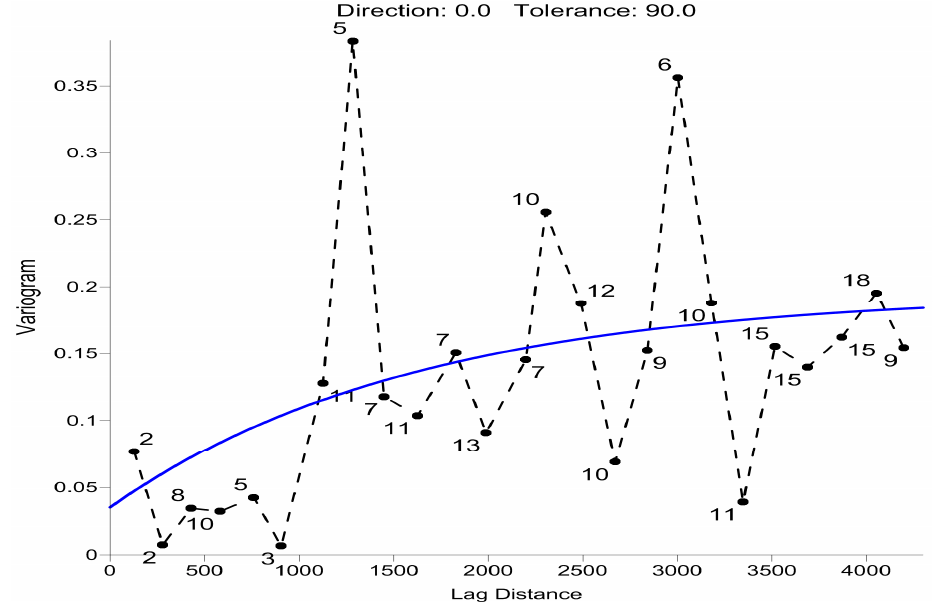
Figure 2. Experimental aperture variogram and model variogram parameters at Bari (Southern Italy) coastal fractured aquifer; Model: Exponential (Scale = 0.16; Length = 3000 m; Anisotropy: ratio = 2, angle = 64.5 degrees; Nugget Effect: error = 0.03518, micro = 0); Experimental: max lag distance = 4300 m, number of lag = 25, lag width = 172 m, vertical scale = 0.384.